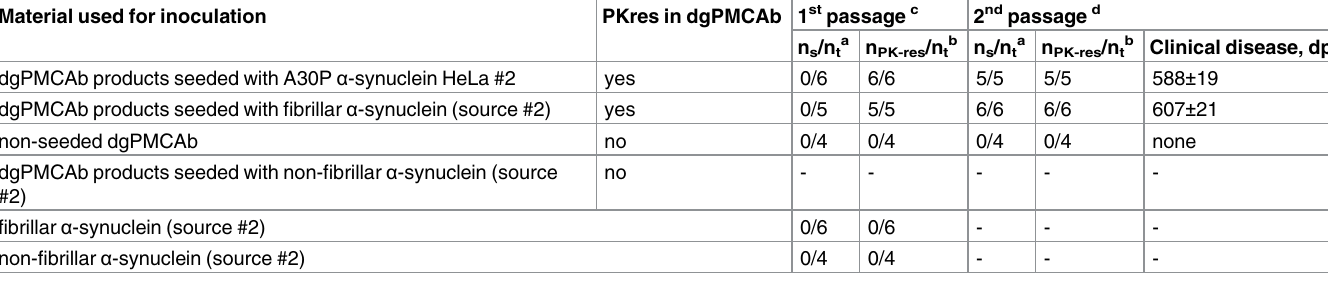
Table 1. Bioassayin Golden Syrian hamsters. Material used for